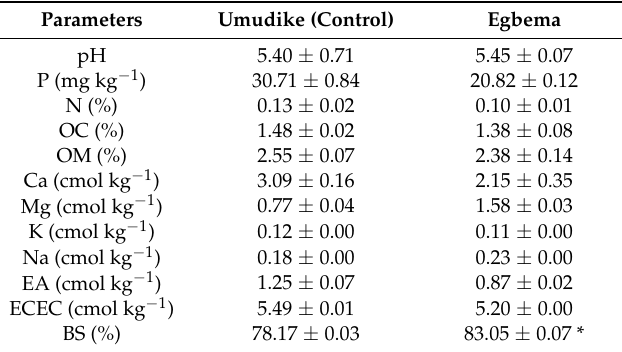
Table 2. Chemical composition of the soils